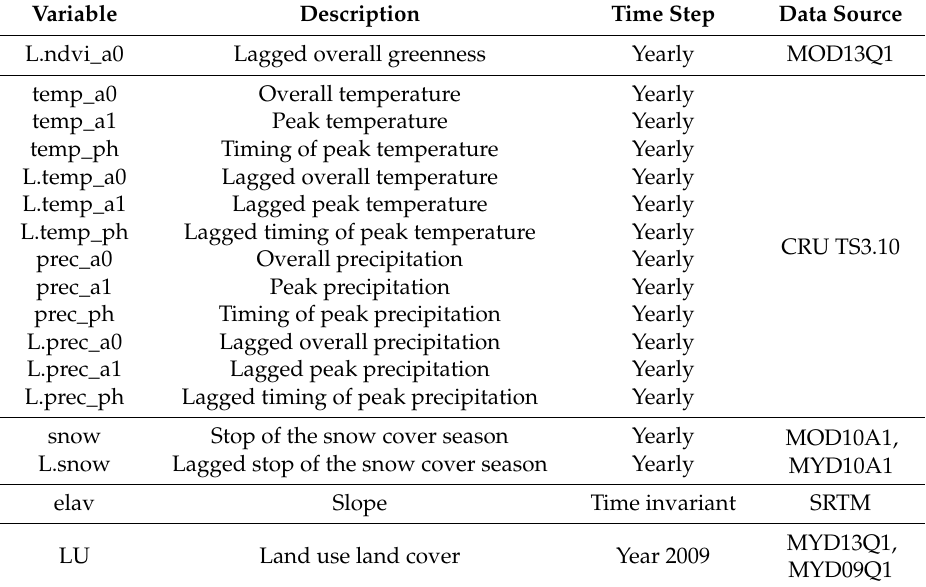
Table 1. Overview of the factors used for statistical